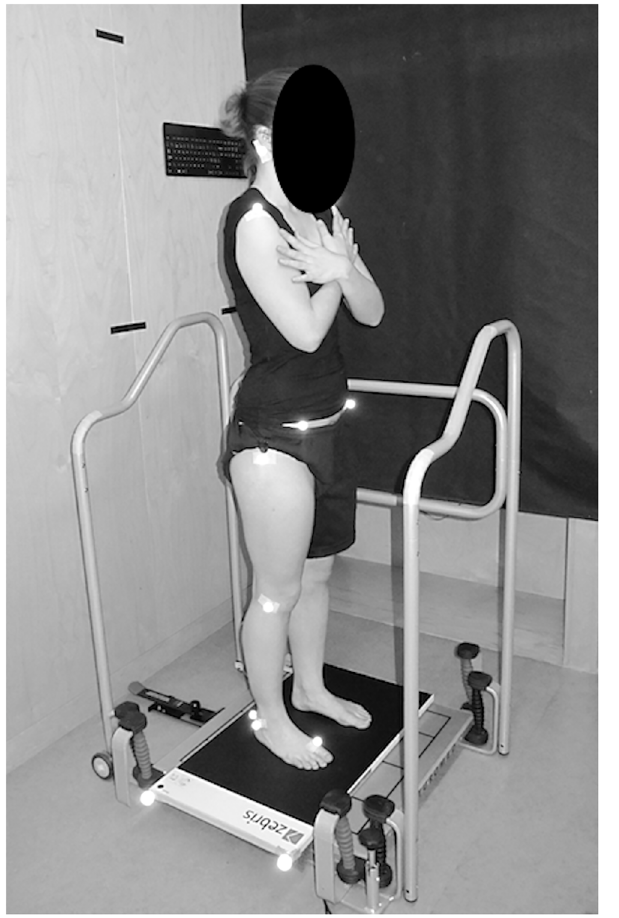
Fig 1. Illustration of the measurement